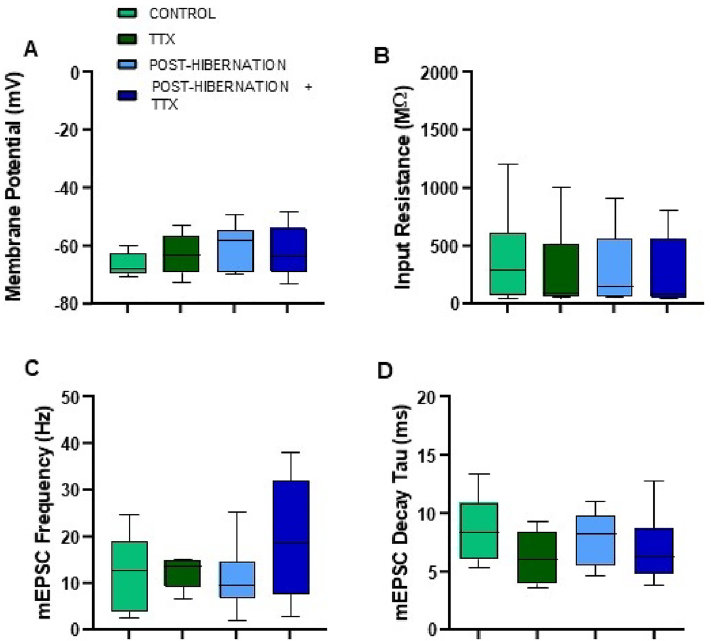
Figure 4. Membrane and other mEPSC properties are not affected following hibernation with or without activity in the post-hibernation period. ( A ) Membrane potential, p = 0.081 (one-way ANOVA); ( B ) Input resistance, p = 0.676 (Kruskal–Wallis test); ( C ) mEPSC frequency, p = 0.403 (Kruskal–Wallis test); ( D ) mEPSC decay time constant, p = 0.061 (Kruskal–Wallis test). Control (n = 18), TTX (n = 19), post-hibernation (n = 17), post-hibernation + TTX (n = 16). Box and whisker plots show the interquartile range. Whiskers extend to maximum and minimum